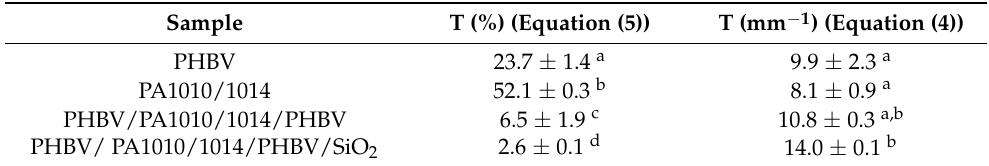
Table 5. WCA values of the mono- and multilayer films of PHBV, PA1010/1014, and SiO 2 micropar- ticles.